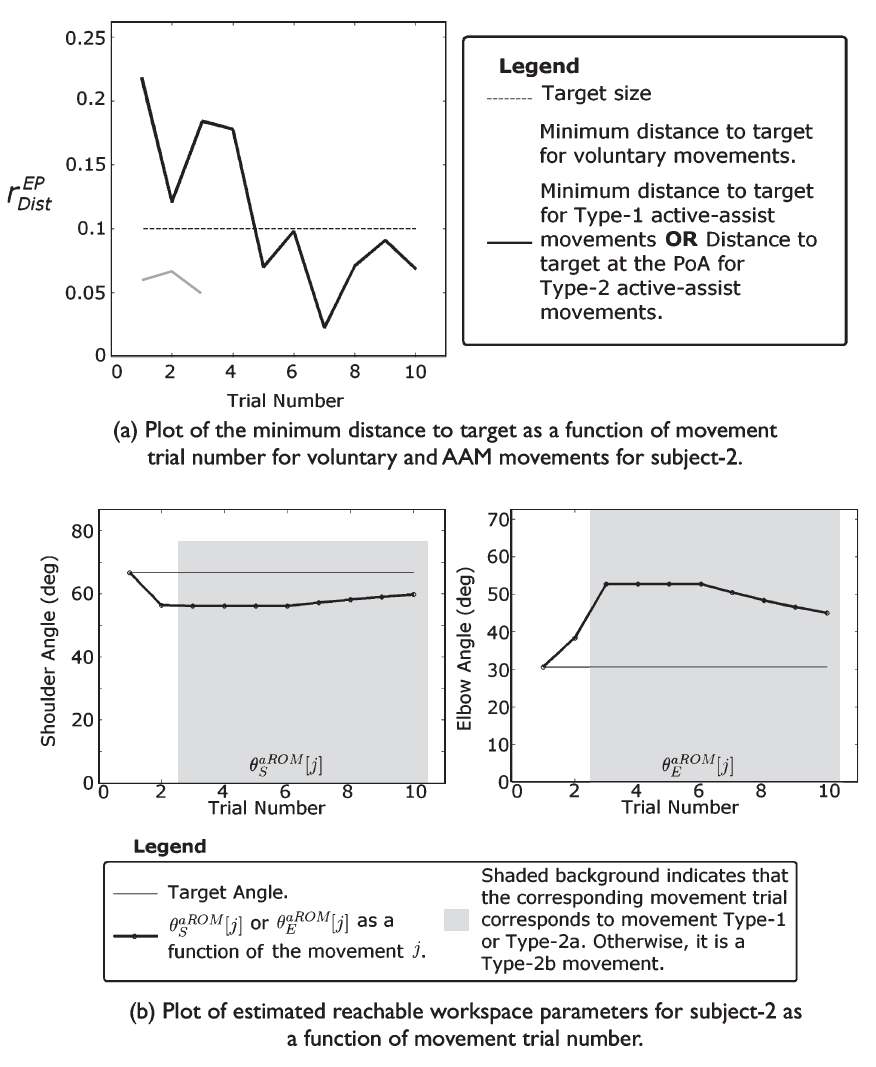
Fig. 11. Demonstration of the trail-by-trial learning of the parameters of reachable workspace for subject-2 reaching to